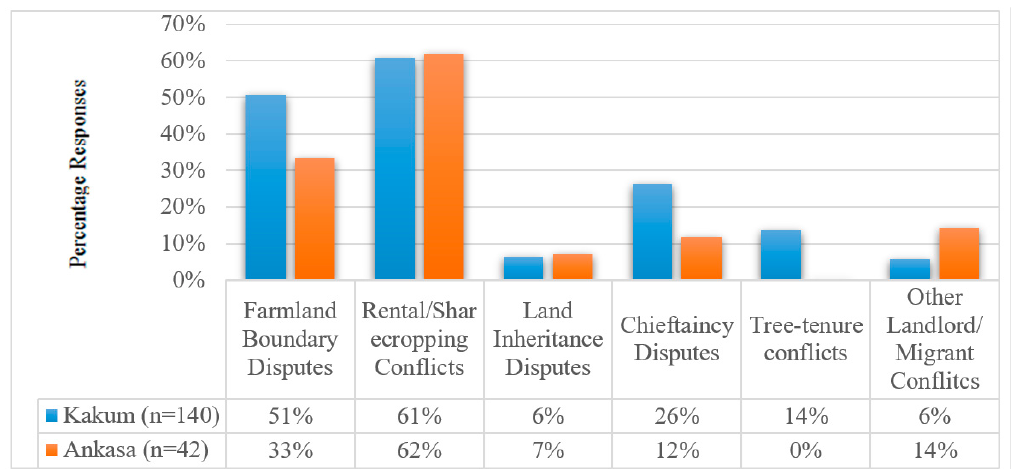
Figure 2. Type of land disputes in the study areas. Figure based on multiple responses on the nature of land disputes. 4 The mean scores of communities were computed by aggregating individual responses to the statement divided by the total number of respondents surveyed in the respective